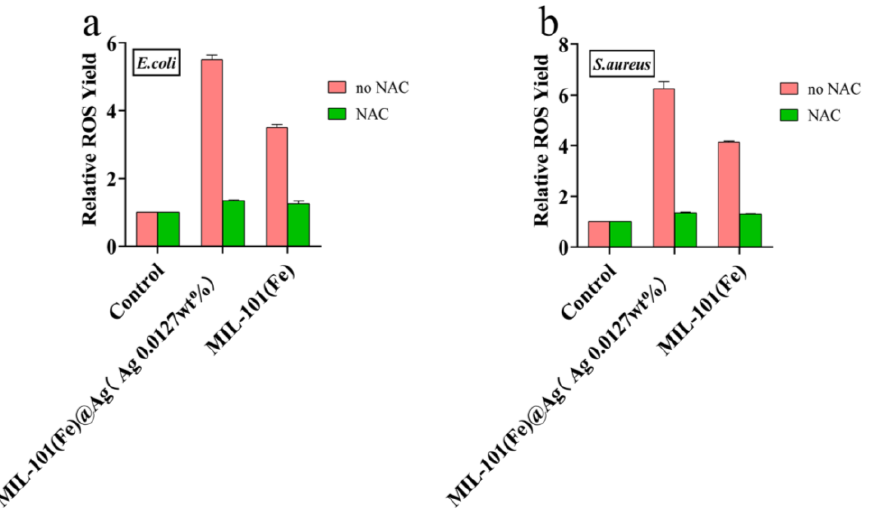
Figure 14. Intracellular ROS production by E. coli ( a ) and S. aureus ( b ) induced by treatment with MIL-101(Fe) and MIL-101(Fe)@Ag (Ag 0.0127 wt%). The content of ROS in all of the treatment groups was normalized to 1 with the control group.